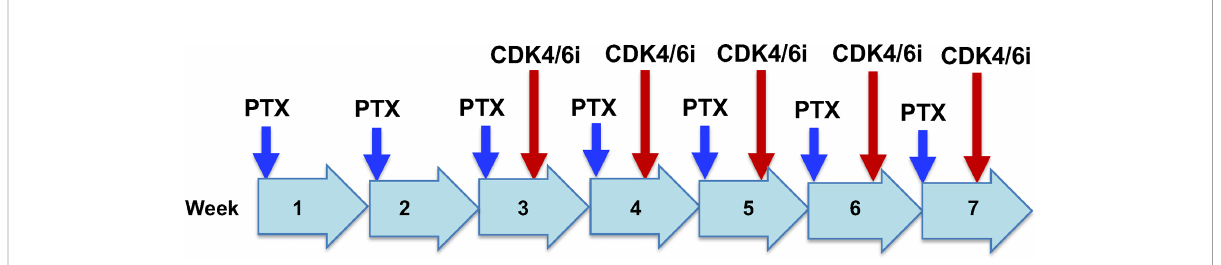
FIGURE 4 Potential clinical trial design for paclitaxel/CDK4/6i combination chemotherapy for recurrant ovarian cancer. Drug administration and schedule are illustrated for a hypothetical dose dense regimen of paclitaxel treatment of recurrant ovarian cancer. Paclitaxel (PTX) will be given alone in weeks 1 and 2. In weeks 3 to 7, paclitaxel will be given on day 1, and CDK4/6i will be administrated on day 6 of the week.It is postulated that paclitaxel alone in week 1 and 2 will eliminate the majority of proliferative cancer cells. In subsequent weeks, CDK4/6i given on day 6 will impair the recovery of damaged cancer cells from exposure to paclitaxel during the previous 5